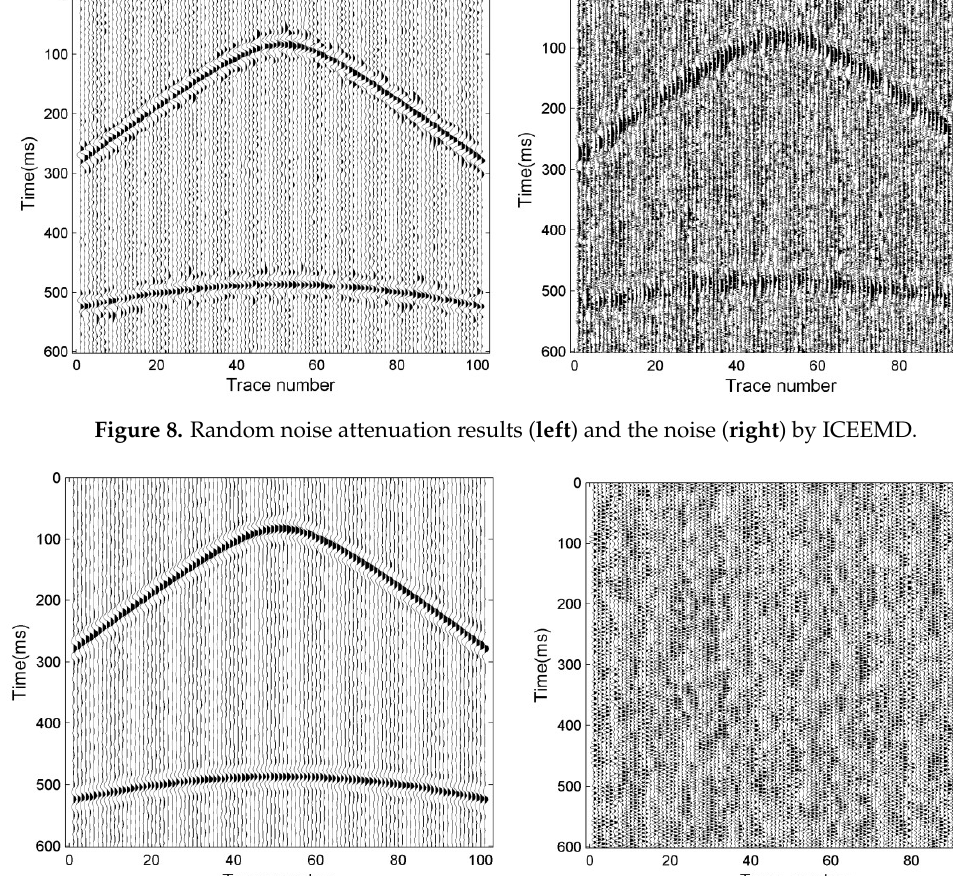
Figure 9. Random noise attenuation results ( left ) and the noise ( right ) by VMDC.